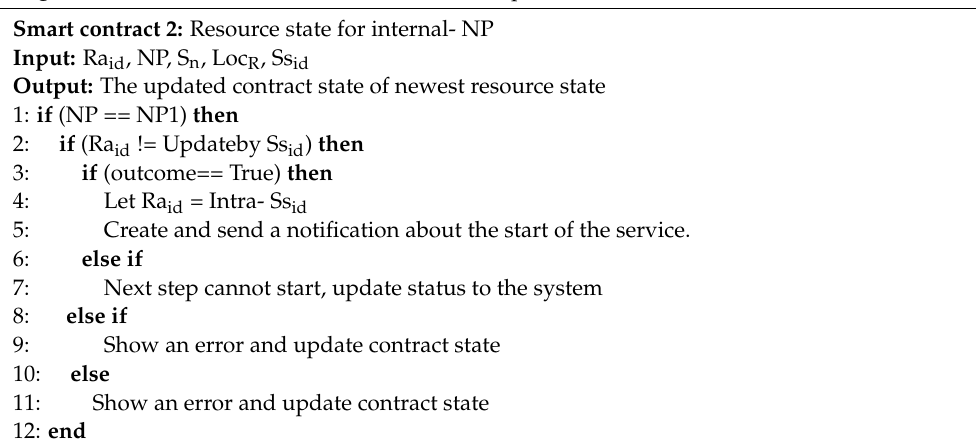
Algorithm 2. Smart contract for internal NP and update ststus to